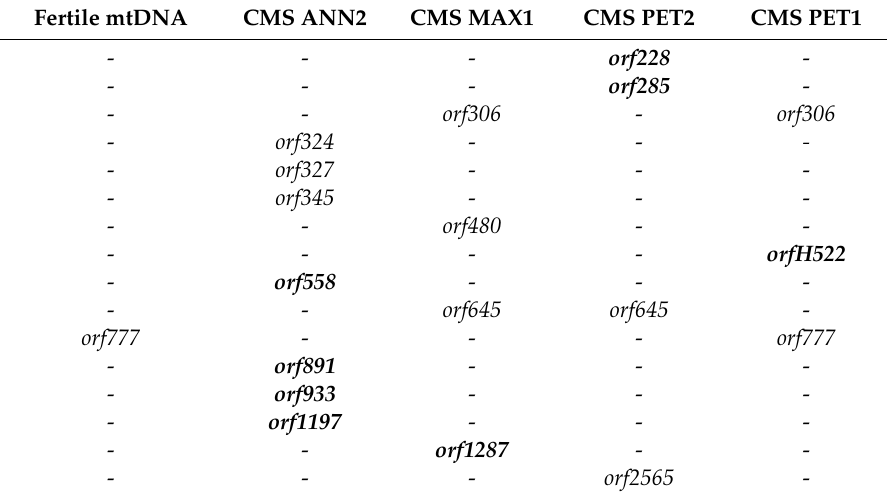
Table 4. Summary of transcriptionally active open reading frames in the mitochondrial genome of isonuclear fertile and CMS